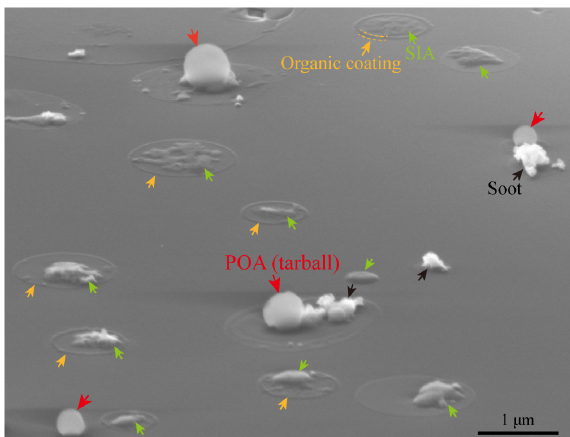
Figure 4. Scanning electron microscope (SEM) image acquired in the secondary electron (SE2) mode at a 75 ◦ tilt angle showing the surface morphology of individual particles in the vertical dimen- sion. The red, black, green, and orange arrows indicate primary organic aerosol (POA) particles (mainly tarballs), soot particles, secondary inorganic aerosol (SIA) particles, and secondary organic coating,